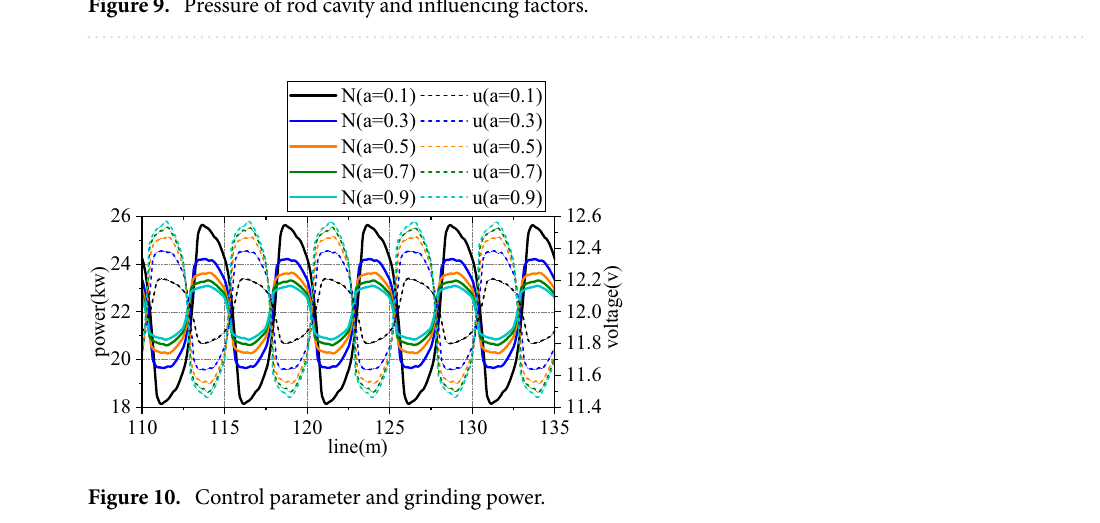
Figure 9. Pressure of rod cavity and influencing factors.